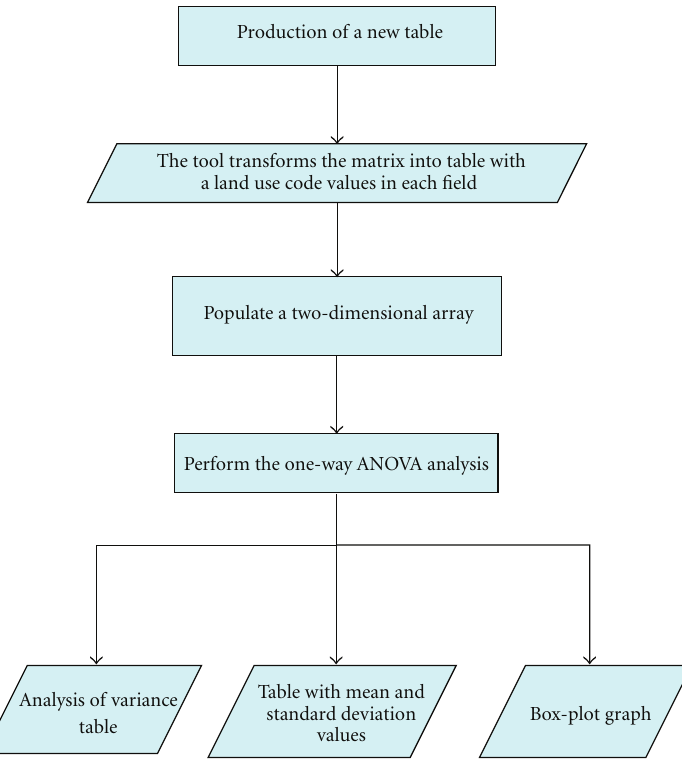
Figure 2: Flow chart of the second step of the